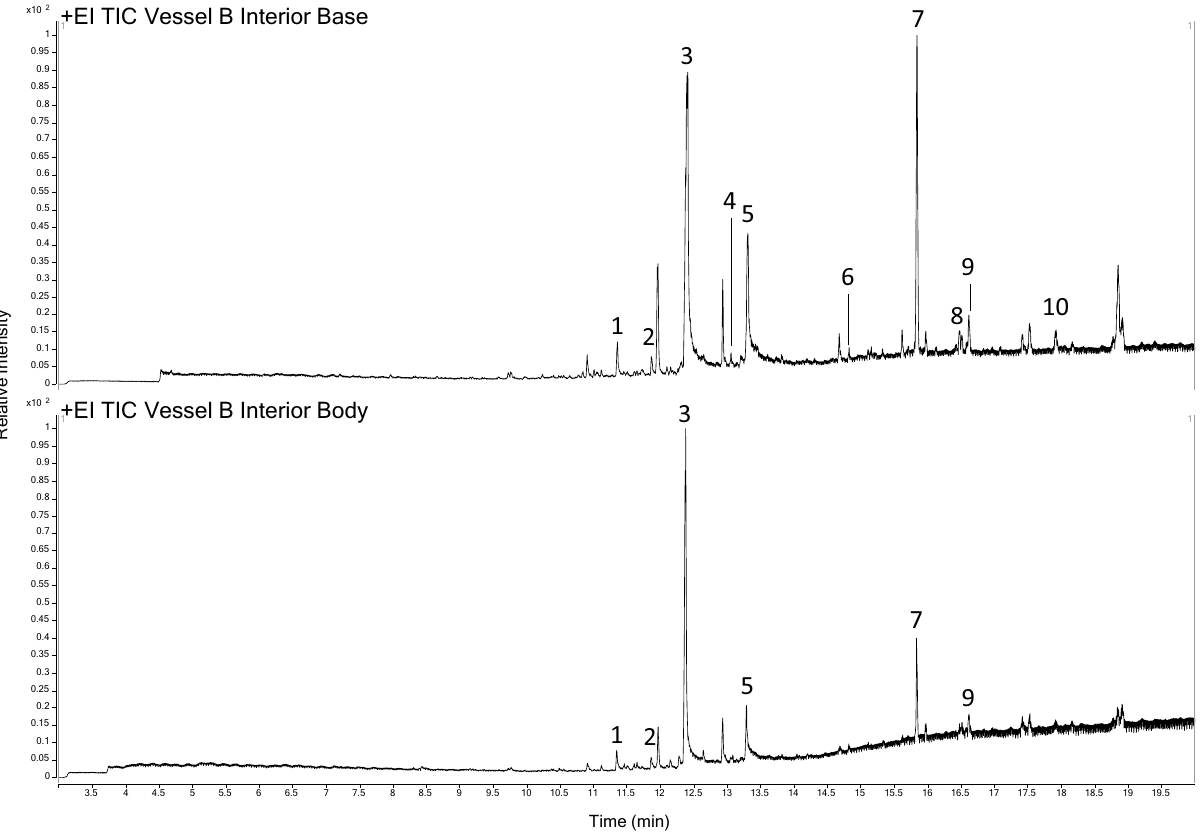
Figure 6. Total Ion Chromatograms obtained from the solid Vessel B corrosion samples Compounds identified: [1] Tetradecanoic acid; [2] Pentadecanoic acid; [3] n-Hexadecanoic acid; [4] aliphatic compound containing